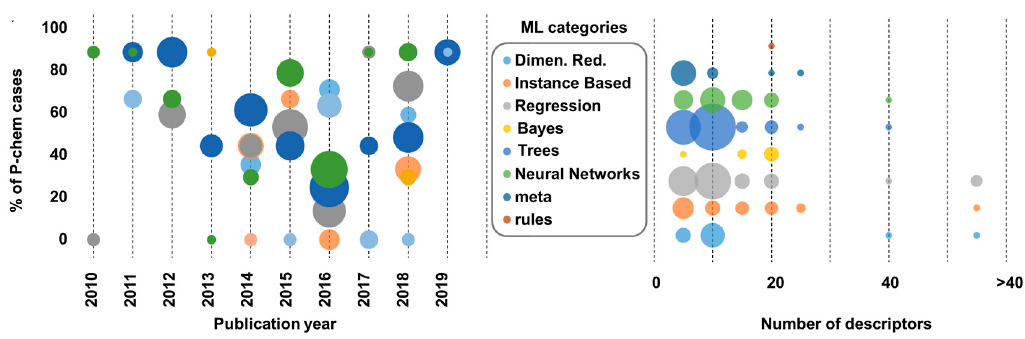
Figure 4. Machine learning categories vs. number of descriptors (right) and vs percentage of p-chem data cases over the years (left).